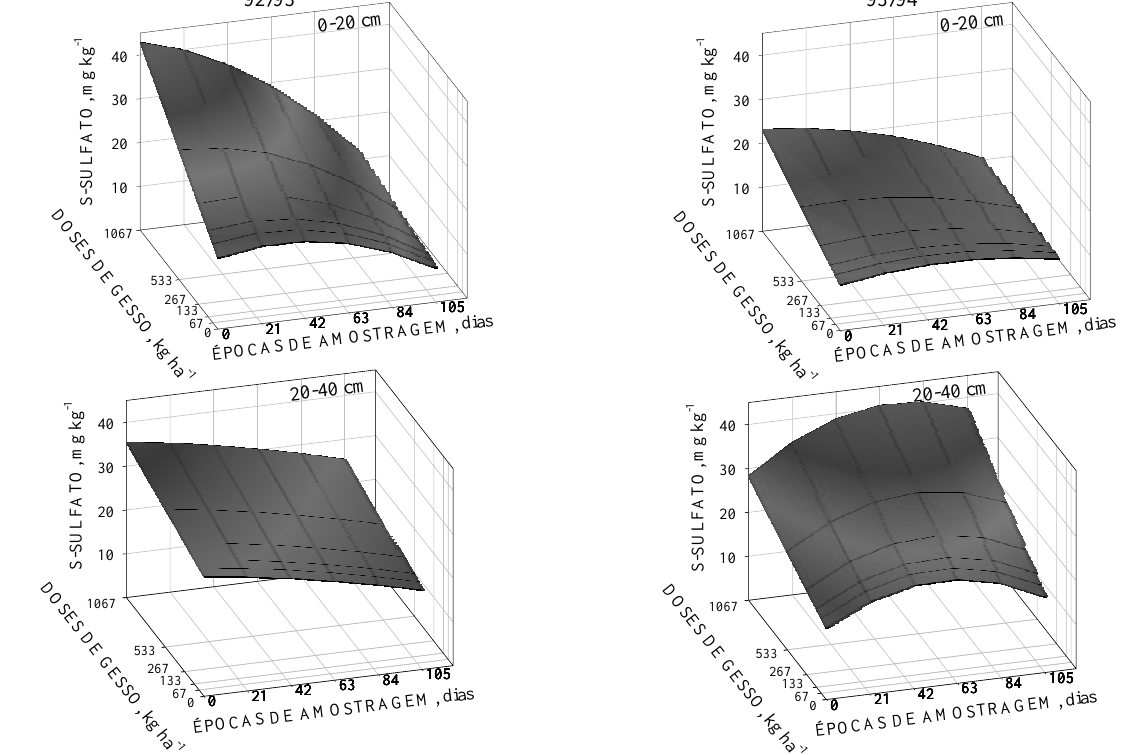
Figura 1. Superfície de resposta, relacionando teores de S-sulfato (y), em função das doses de gesso agrícola (x) e das épocas de amostragem (z) em duas profundidades de um Latossolo Vermelho distrófico = 16,27 + 0,105x + típico cultivado com soja nos anos agrícolas de 1992/93 e 1993/94. yˆ (92/93: 0-20 cm) = 27,30 - 0,57x + 0,00756z - 0,00031x 2 - 0,000001z 2 0,025z - 0,0018x 2 - 0,0000019x.z (R 2 = 0,50*); yˆ (92/93: 20-40 cm) - 0,0000083x.z (R 2 = 0,40*); yˆ = 10,32 + 0,087x + 0,12z - 0,00085x 2 + 0,00000043z 2 - 0,00011x.z (93/94: 0-20 cm) (R 2 = 0,47*); yˆ = 16,13 + 0,28x + 0,011z - 0,0026x + 0,0000029z 2 + 0,000074x.z (R 2 = 0,67*). * = (93/94: 20-40 cm) equação significativa a 5% pelo teste